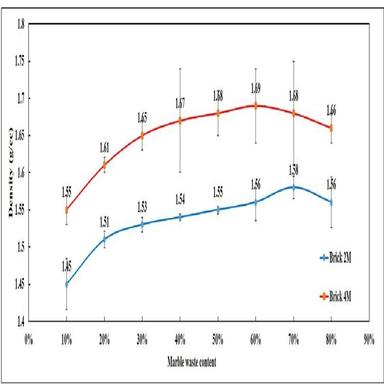
Bulk densities of hybrid composite hybrid geopolymeric composite samples prepared at different molarities and marble waste content.